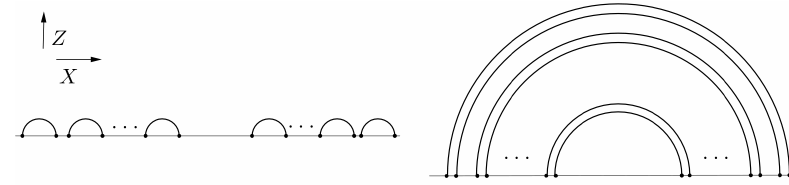
Figure 6 . Constraints that arise when N = 2 . Since we have set p + that θ = 2 tan − 1 semicircle, as shown.